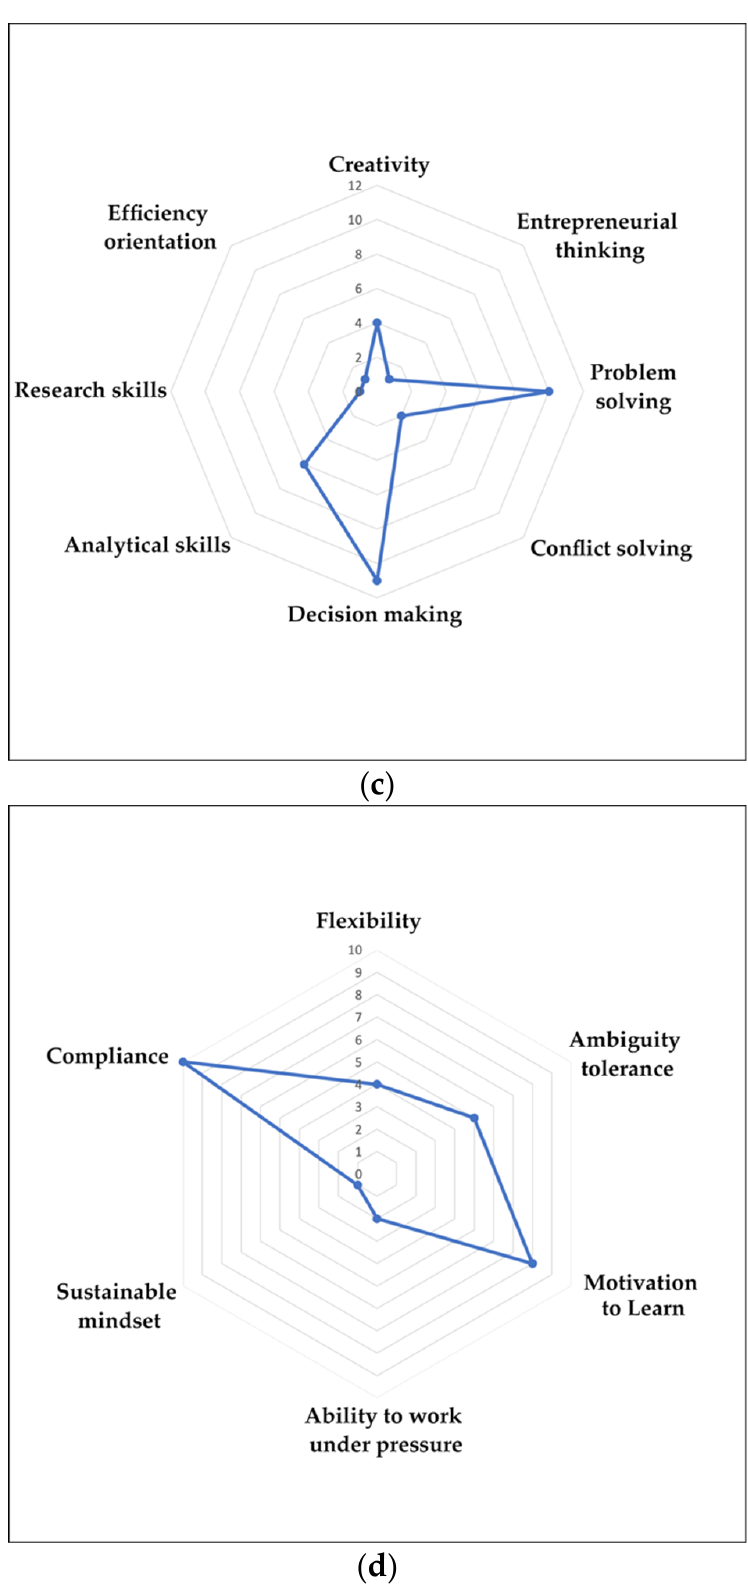
Figure 2. ( a ) Radar chart of technical competence based on the number of citations; ( b ) radar chart of methodological competence based on the number of citations; ( c ) radar chart of social competence based on the number of citations; ( d ) radar chart of personal competence based on the number of citations.